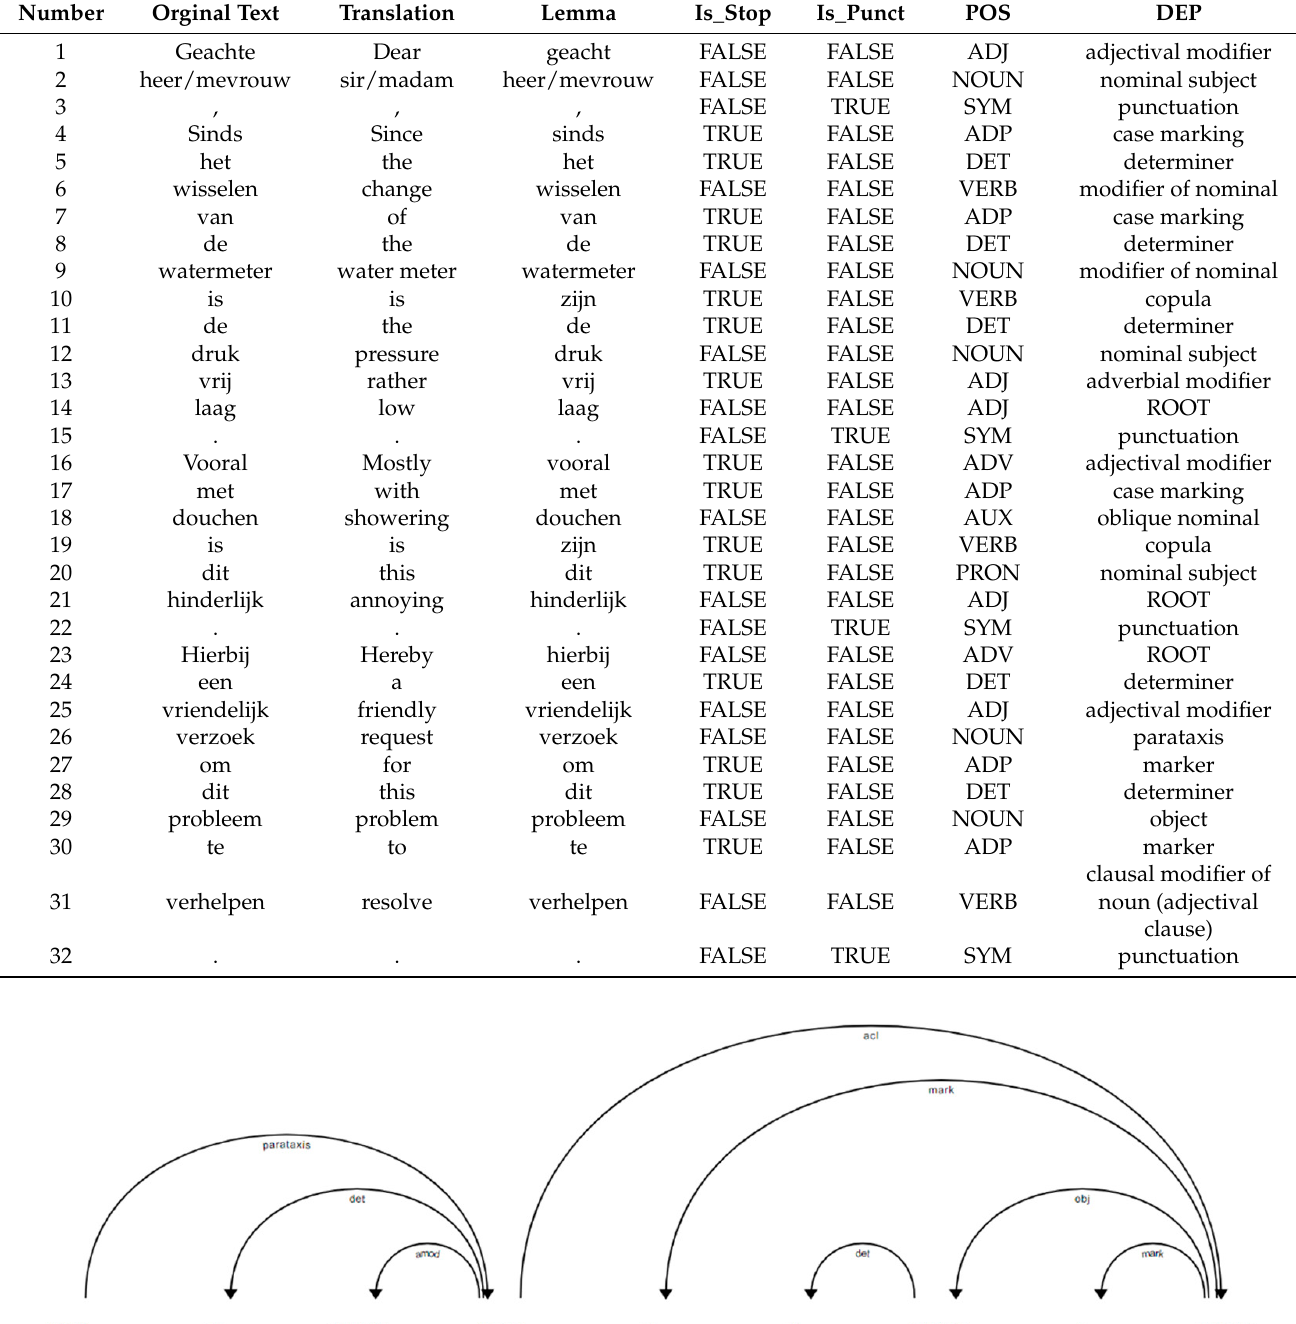
Table 1. Original text and tokenized text with lemma, part of speech, stop words, and punctuation. Note that the column ‘translation’ is only added to facilitate reading by non-Dutch readers. The translation is not needed for the lexical and syntactic analysis of the complaints.